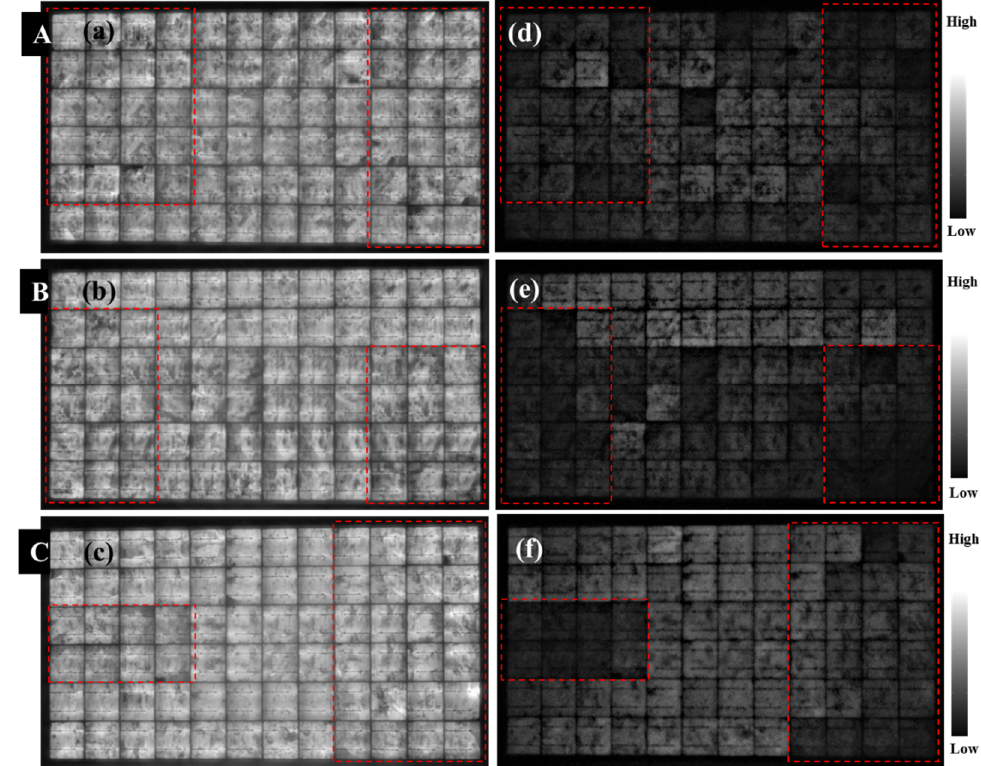
Figure 6. EL analyses of the 3 old solar panels under I sc ( a – c ) and 0.1 I sc ( d – f ) conditions, respectively. Corresponding PID affected areas in EL images under both bias conditions are marked out in red. EL at 0.1 I sc revealed PID affected areas better.